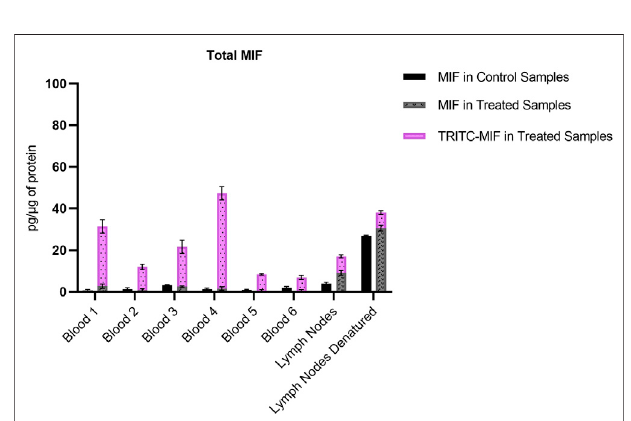
FIGURE 7 | Comparison of the total amount of MIF, both as adducted and non-adducted MIF, in the control and treated samples analyzed. Levels expressed as pg per µg of total